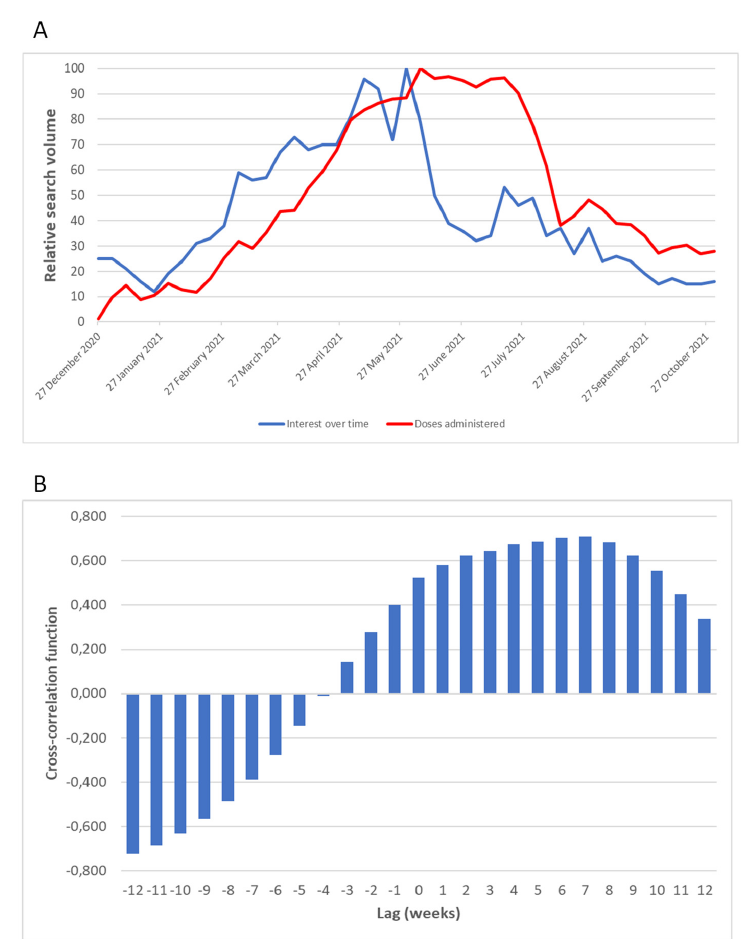
Figure 3. Relationship between Google Trends data and the number of COVID-19 vaccinations. ( A ) Comparison between the overall trends of search interest for the keyword Vaccine (Argument) and the number of vaccine doses administered per 100,000 inhabitants; ( B ) cross-correlation coefficients between the search interest for the keyword Vaccine (Argument) and the number of vaccines administered.